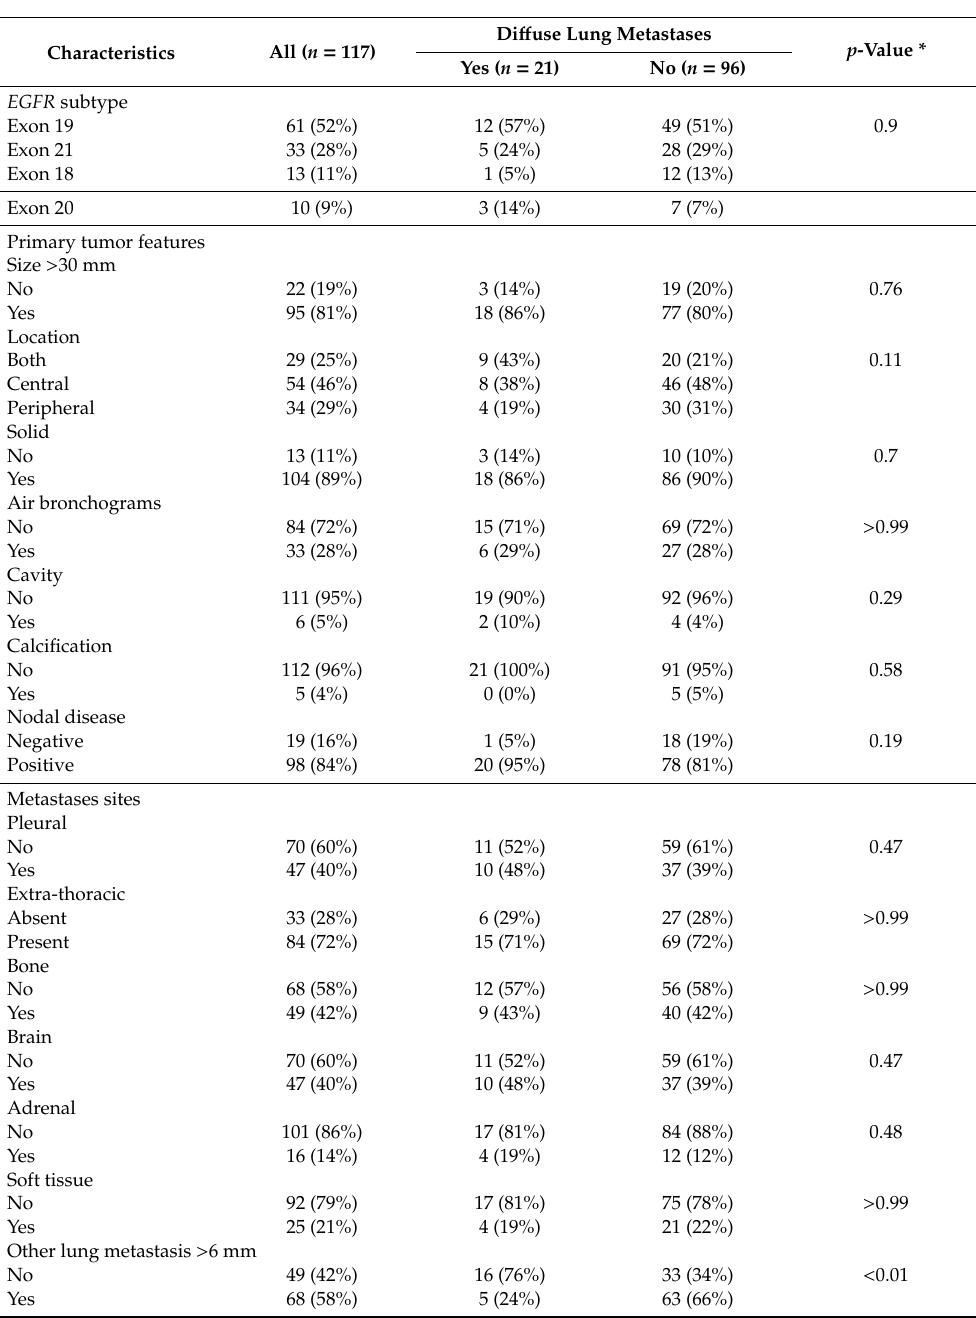
2.3. Multivariable Regression Model for Presence of Di ff use Lung Metastases in The Setting of EGFR-Mutation Age ( ≥ 63, < 63), zone, and lung metastases > 6mm are significant predictors of whether patients had di ff use lung disease metastases or not. When holding the other covariates fixed, among EGFR -mutant patients, the odds of having di ff use lung metastases are 87% lower in those with lung metastases > 6 mm than those without lung metastasis > 6 mm (OR: 0.13, 95% CI: